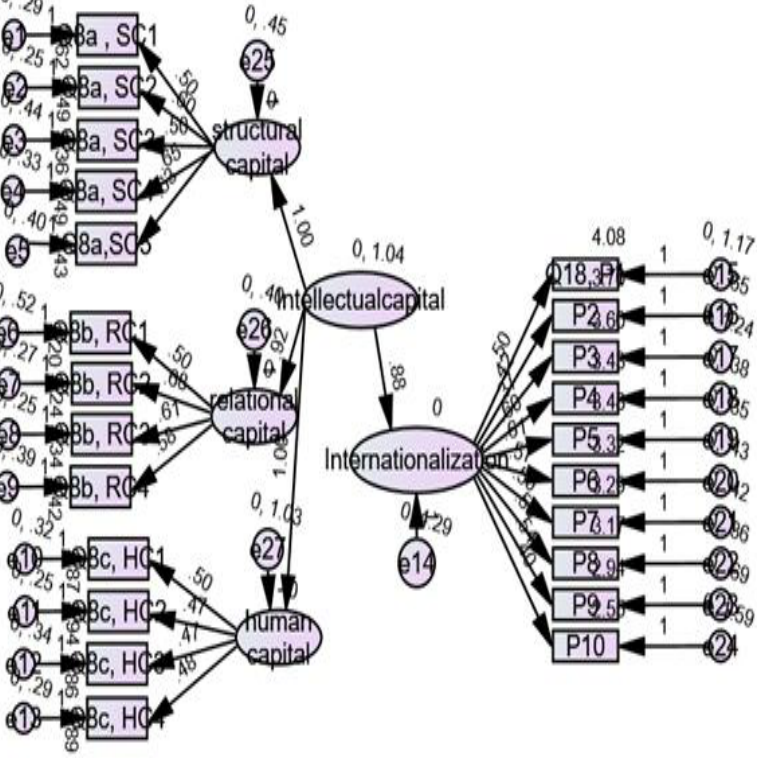
Fig. 3: SEM model for intellectual capital